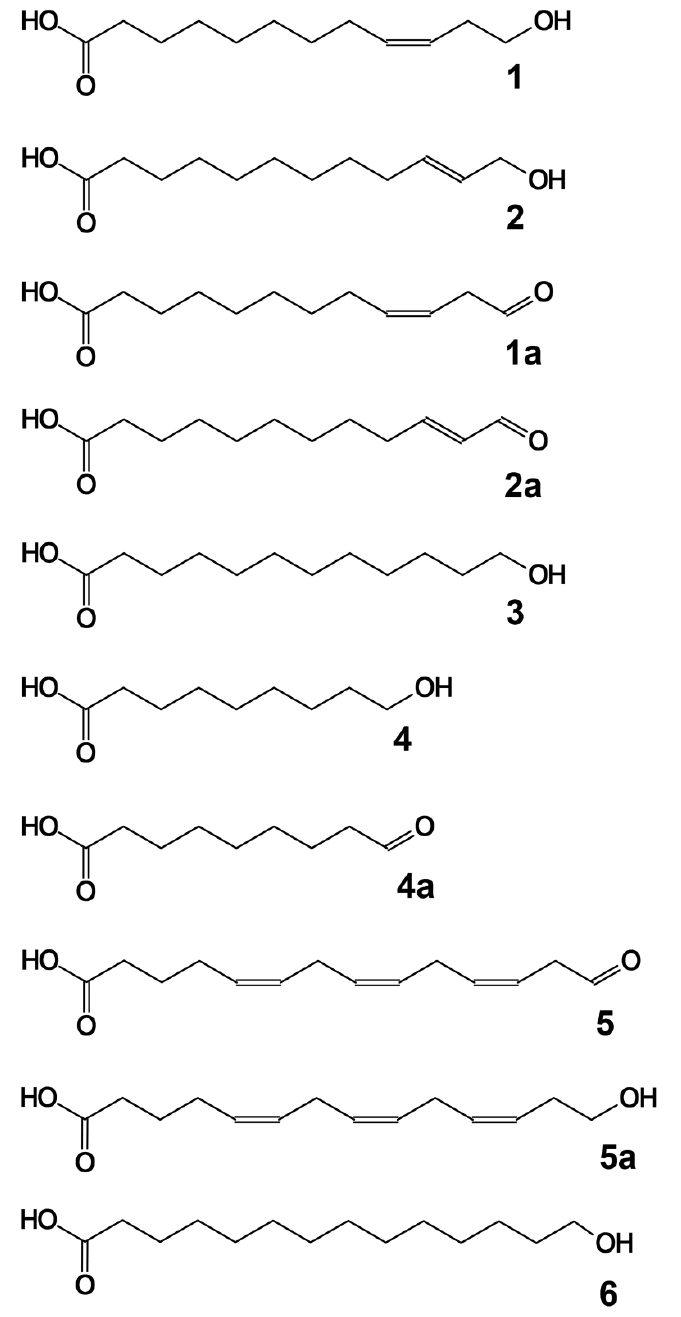
Figure 5. The structural formulae of major detected products and their derivatives: 1 , (9 Z )-12-hydroxy-9-dodecenoic acid; 1a , (9 Z )-12-oxo-9-dodecenoic acid; 2 , (10 E )-12-hydroxy-10-dodecenoic acid; 3 , 12-hydroxydodecanoic acid; 4 , 9-hydroxynonanoic acid; 4a , 9-oxononanoic acid; 5 , 14-hydroxy-5,8,11-tetradecatrienoic acid; 5a , (all- Z )-14-oxo-5,8,11-tetradecatrienoic acid; 6 , 14-hydroxytetradecanoic acid. Both 13-HPOT and 13-HPOD incubations yielded a single predominant product, 1 , with a retention time of 10.3 min (Figure 6A,B). The mass spectrum of this NaBH 4 -reduced product (Me/TMS) possessed the following diagnostic and prominent fragments: [M–Me] + at m / z 285 (1%), [M–CH 2 OTMS + TMS] + at m / z 270 (5%), [285–MeOH] + at m / z 253 (6%), [M–TMSOH] + at m / z 210 (5%), [210–MeOH] + at m / z 178 (13%), m / z 159 (12%), m / z 123 (31%), [CH 2 =O + –SiMe 3 ] at m / z 103 (100%), and [SiMe 3 ] + at m / z 73 (86%). The spectrum of compound 1 matched that for (9 Z )-12-hydroxy-9-dodecenoic acid